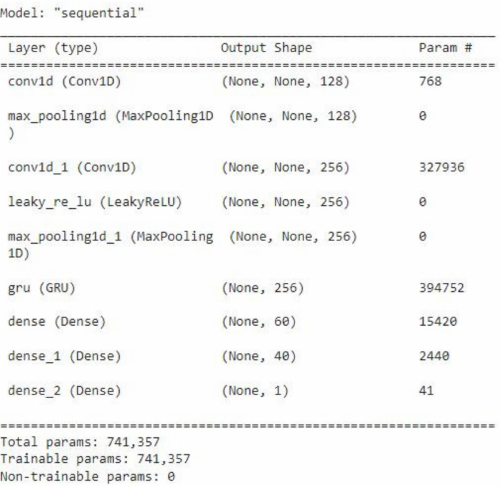
Figure 5. Capture of the model in the Google Colab